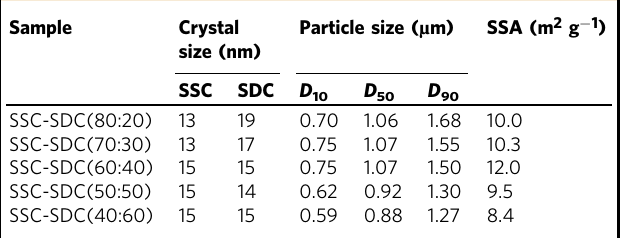
Table 1 Crystal size and particle size of nanocomposite